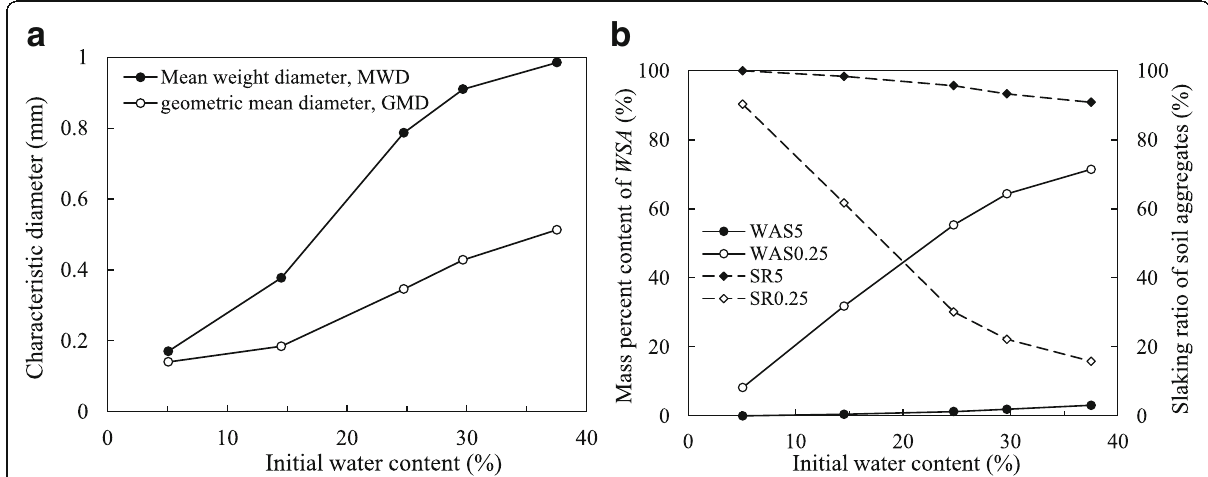
Fig. 8 ( a ) Characteristic diameters of soil aggregates; ( b ) variations of water stability and slaking ratio of water stable aggregates under